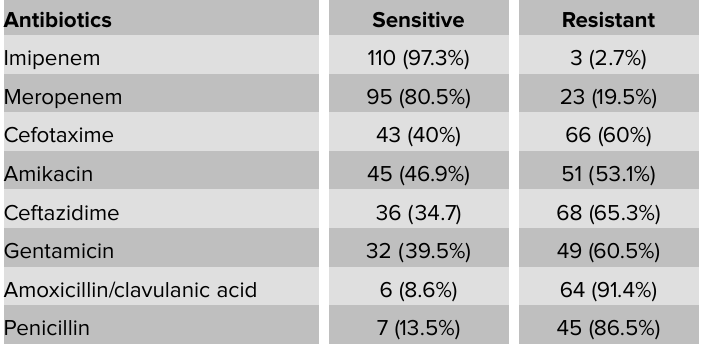
Table 3: Frequencies of antibiotic susceptibility of the gram-negative